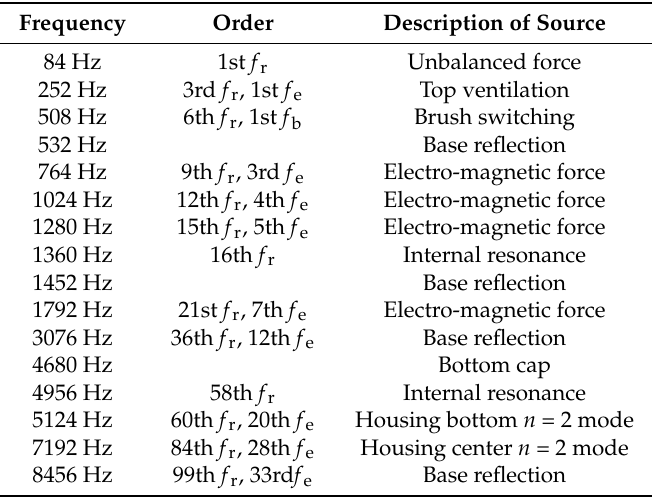
Table 2. Description of source particle velocity reconstruction.